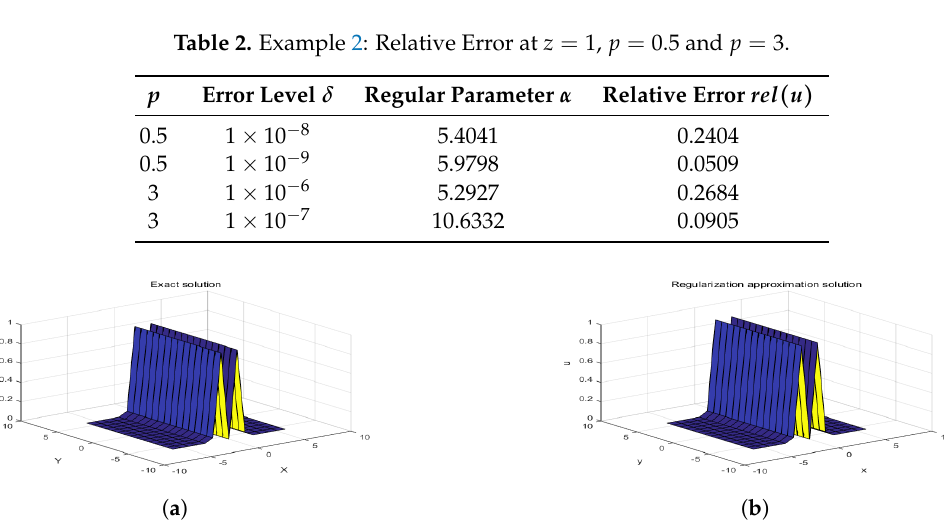
Figure 2. Example 1: δ = 1 × 10 − 10 , z = 0.3: ( a ) Exact solution, and ( b ) approximation solution.